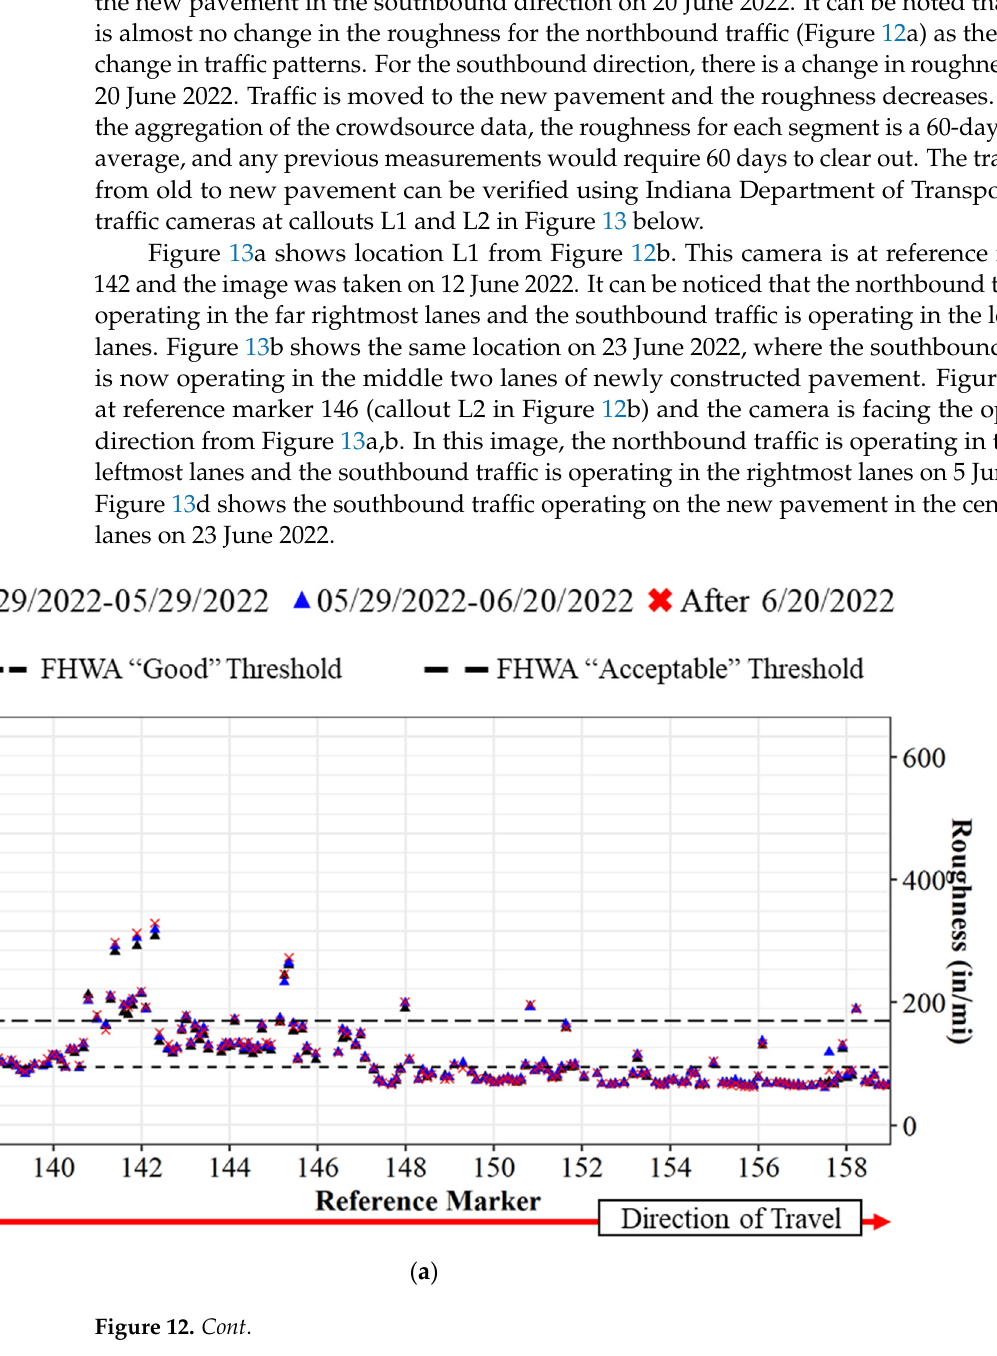
Figure 11. I-65 pavement distress validation points: ( a ) I-65 northbound reference marker 141.3; ( b ) I-65 northbound reference marker 145.3; ( c ) I-65 southbound reference marker 145.3; ( d ) I-65 south- bound reference marker 141.1. Callout (i) pavement spotting; (ii) rumble strips in driving lane; (iii) depression in pavement; (iv) pothole.